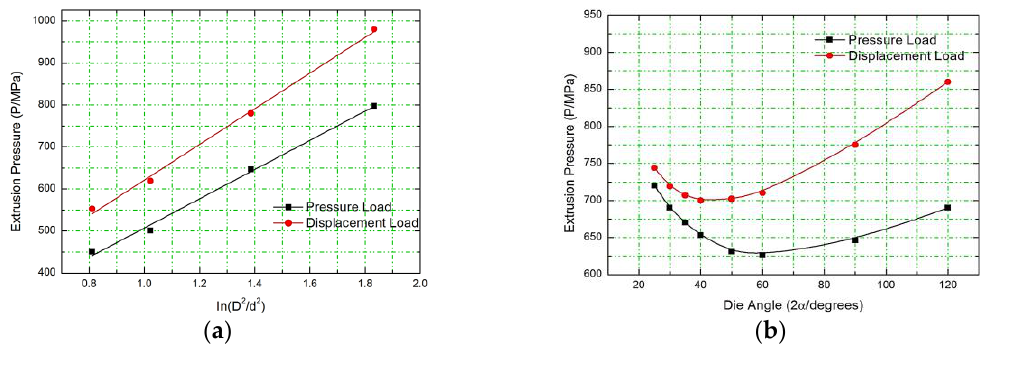
Figure 10. Stress state ratio distribution of ( a ) displacement-load model and ( b ) pressure-load model at 2α = 30°, 40°, 45°, 60°, 90° and 120°.